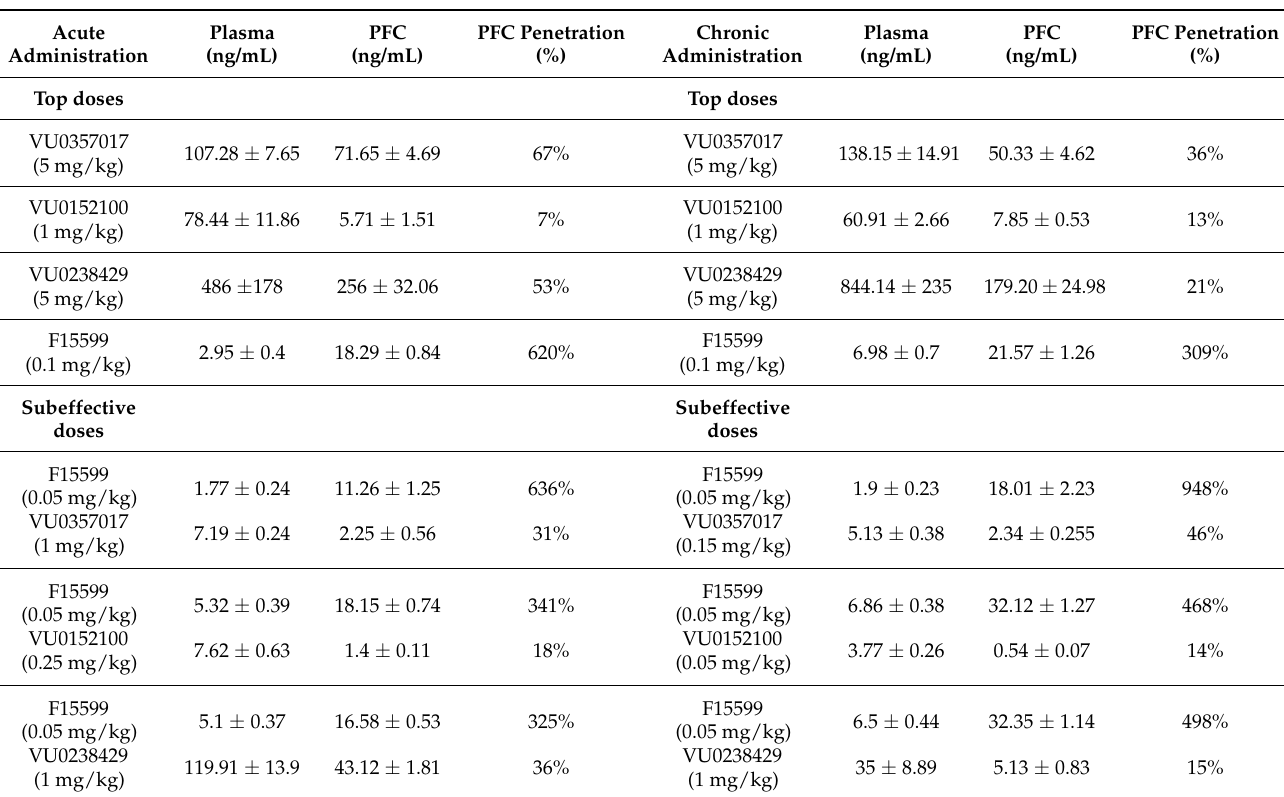
Table 1. Pharmacokinetic analysis of the FC penetration of the drugs administered at the highest doses alone and the combined administration of the compounds at the subeffective doses. The compounds were administered both acutely and for seven days along with